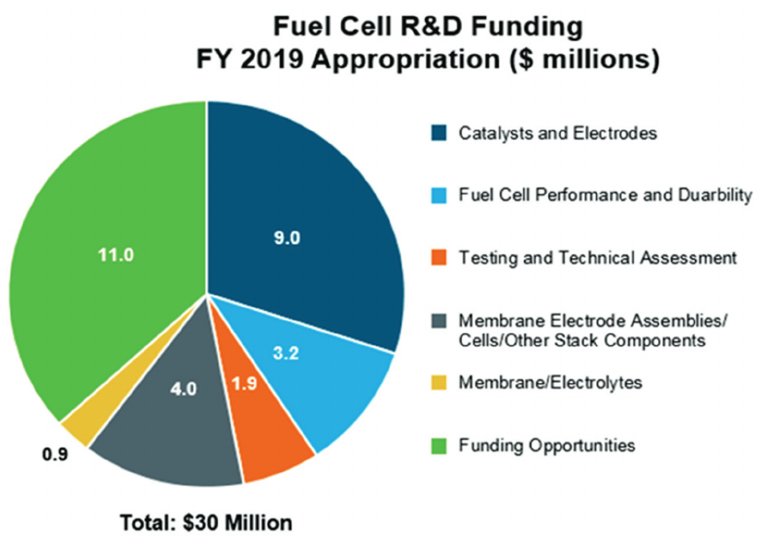
Figure 3. USDOE Research investment supporting fuel cell R&D Program [8]. Adapted and reproduced from the report by United States Department of Energy (2020), © Office of Scientific and Technical Information, 2020.